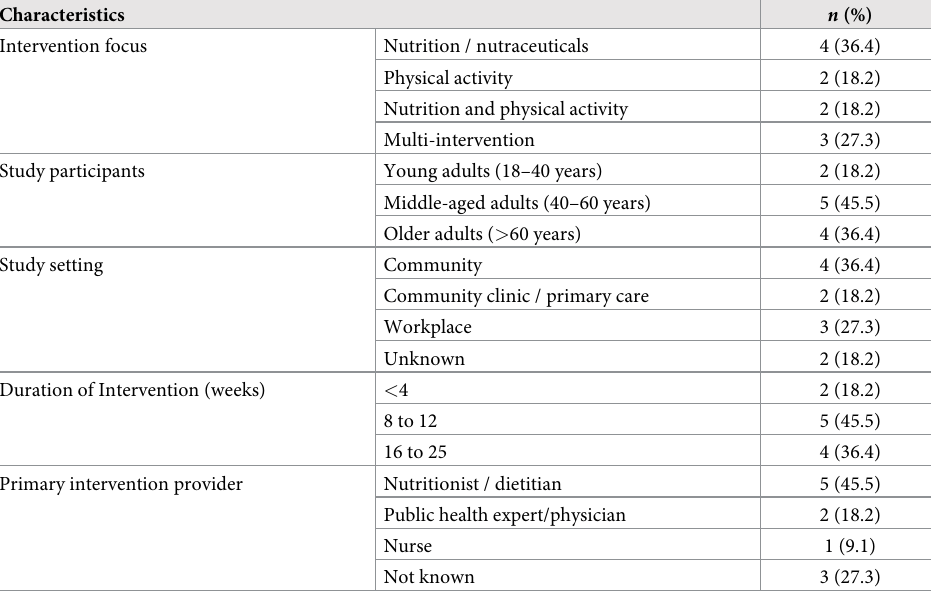
Table 1. Summary of intervention characteristics of the included studies ( n =